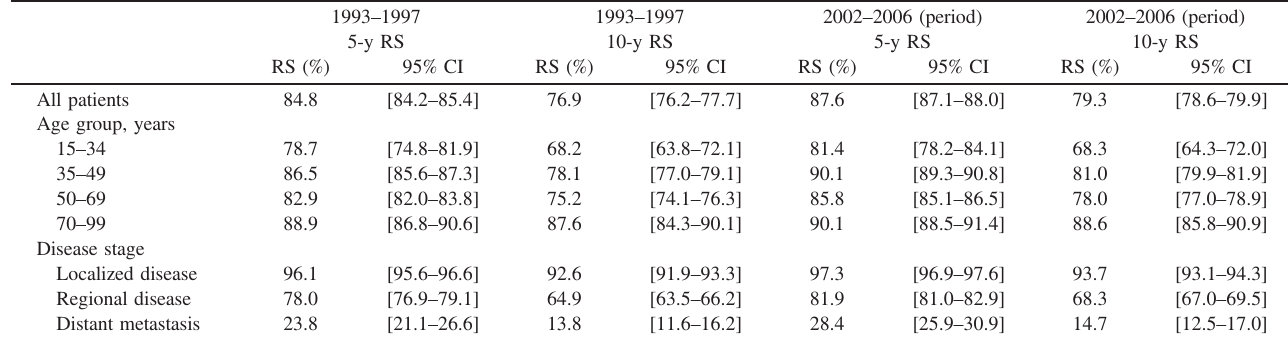
Table 2. Five- and 10-year relative survival by age and stage at diagnosis